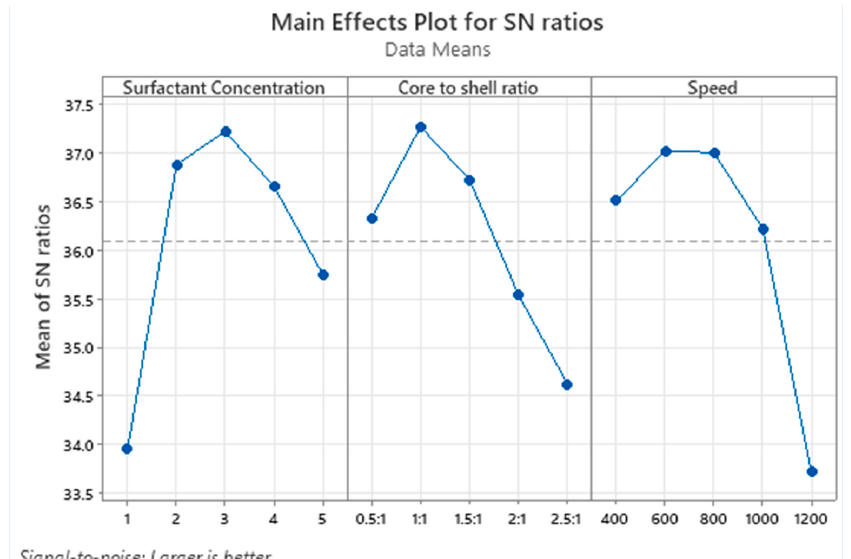
Figure 2. Main effects plots of the SN ratio.